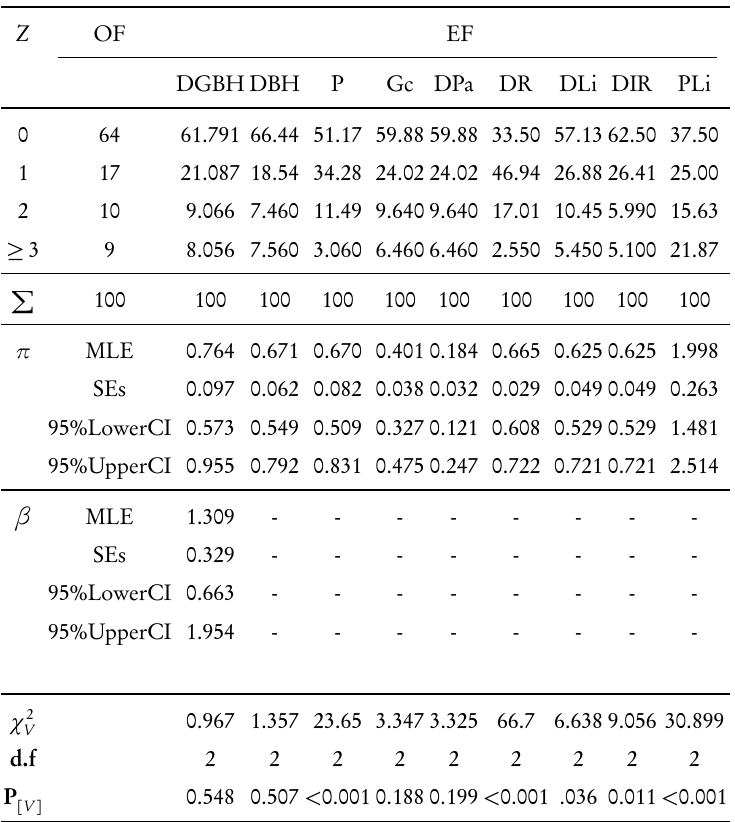
and P [ for carious teeth V ] V